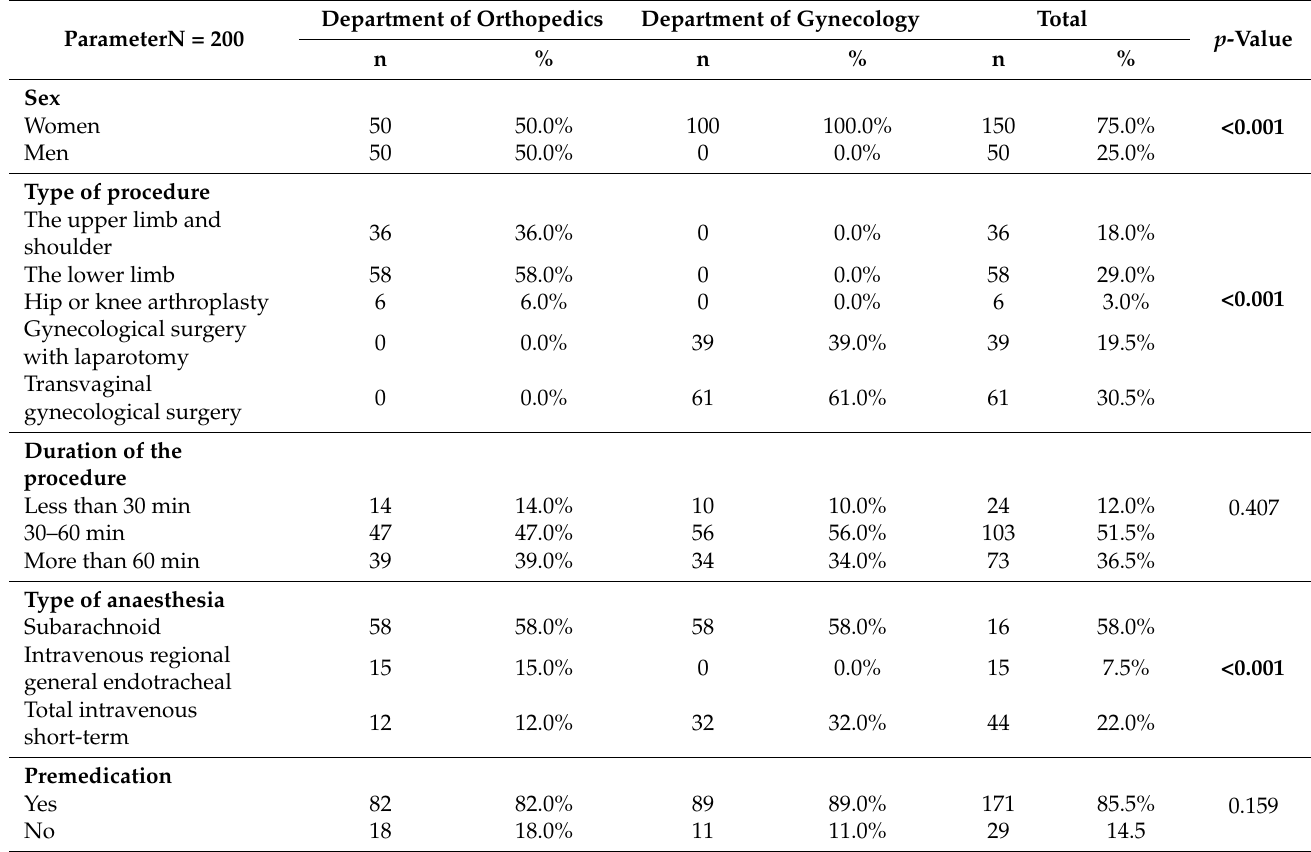
Table 1. Characteristics of the study